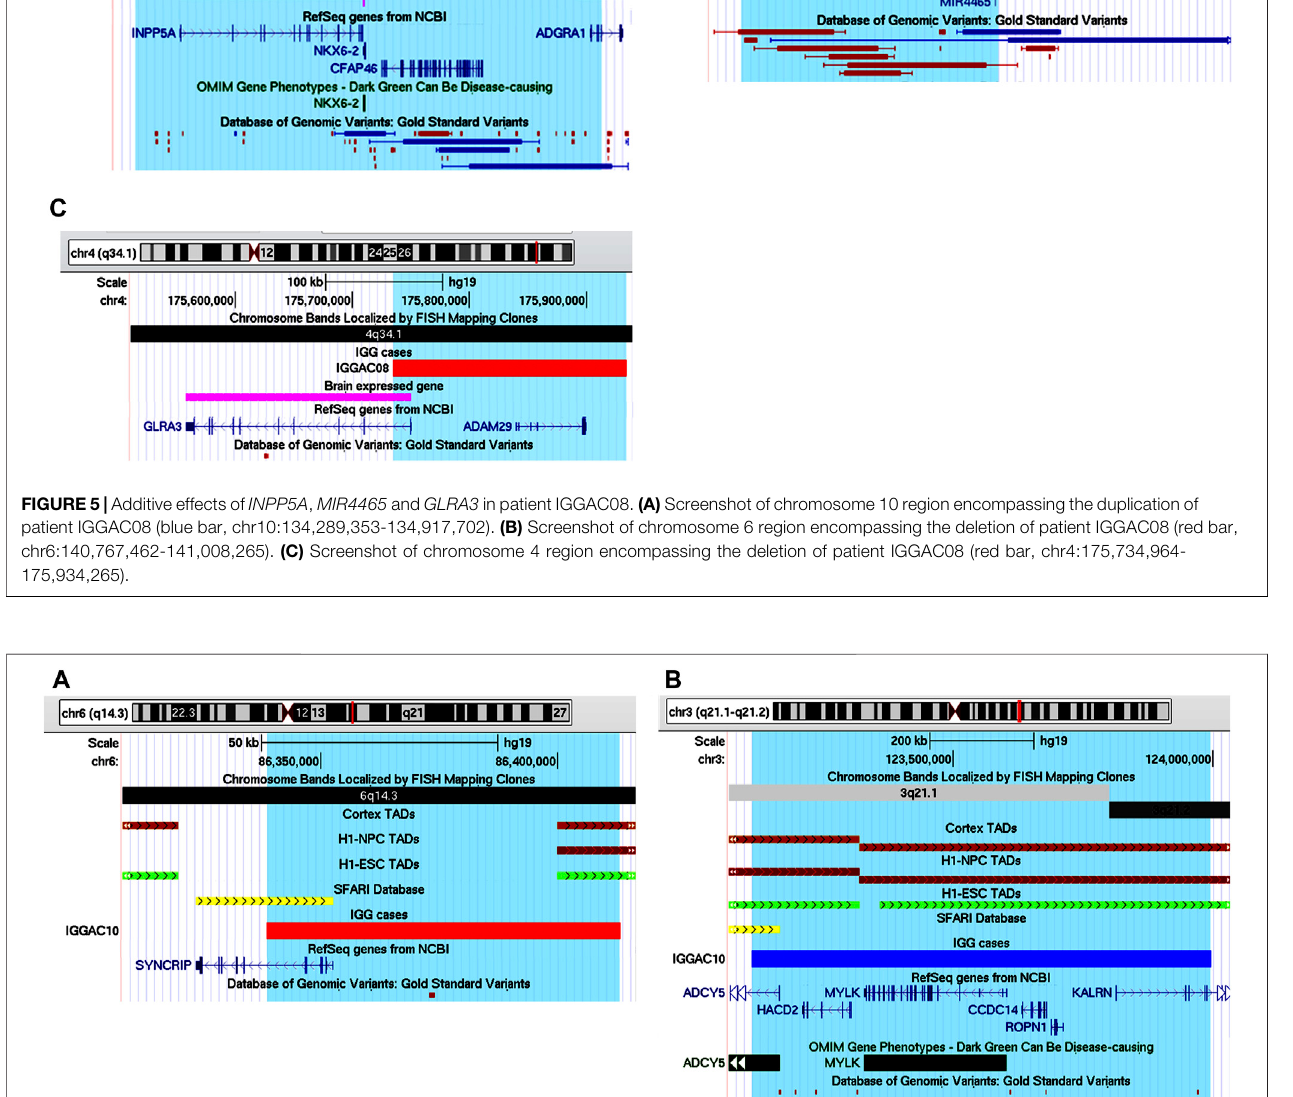
Frontiers in Genetics |